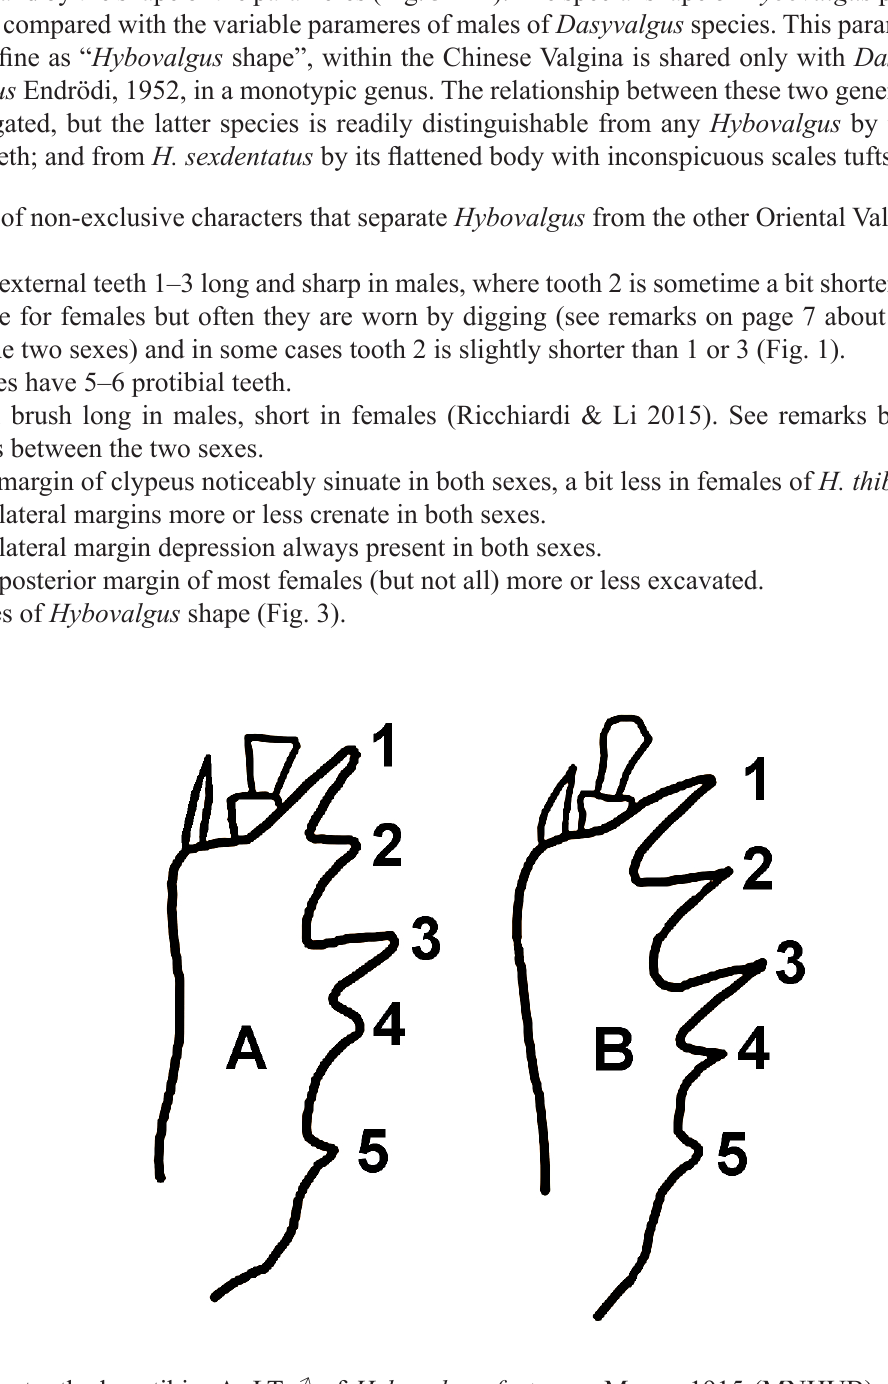
Fig. 1. Five-toothed protibia. A . LT ♂ of Hybovalgus fraternus Moser, 1915 (MNHUB). B . LT ♂ of Hybovalgus fulvosquamosus Moser, 1904